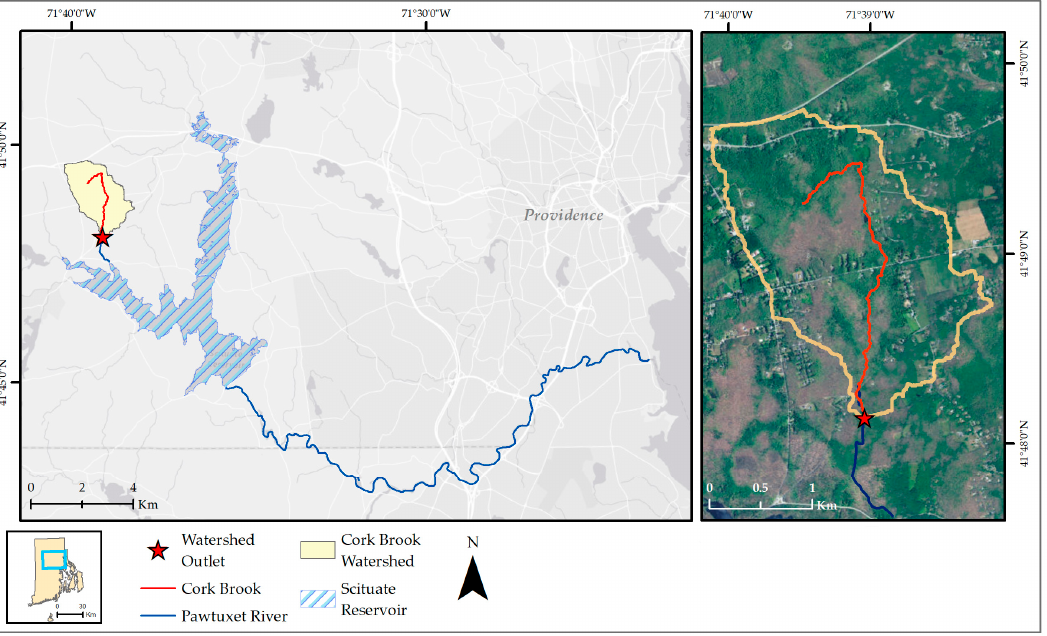
Figure 1. The Cork Brook watershed empties into the Scituate Reservoir, the main drinking water supply for the City of Providence, Rhode Island, USA.